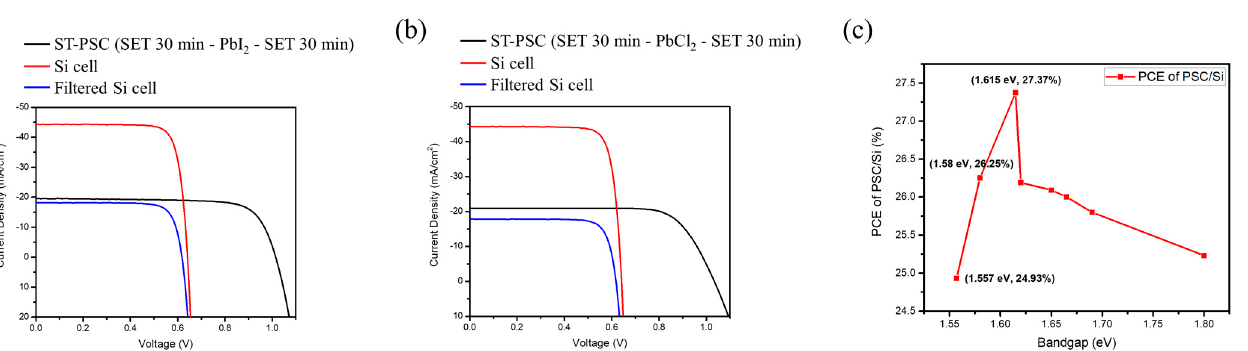
Table 5. Summary of the photovoltaic parameters of the semitransparent perovskite cell, silicon cell, filtered silicon cell, and the summed 4T perovskite/silicon tandem solar